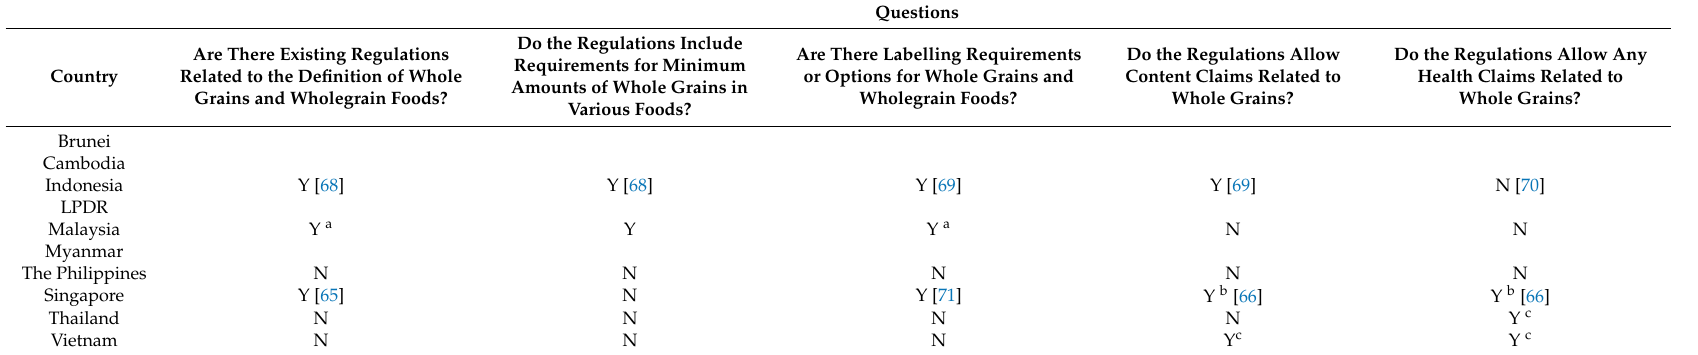
Table 4. An overview of whole-grain-related regulations and health claims specific to each ASEAN